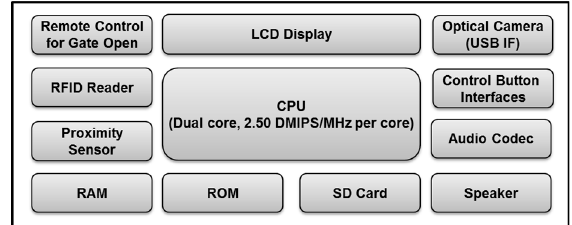
Figure 8. The hardware configuration of the proposed user-friendly stand-alone access control system based on human face recognition at a distance with RFID. DMIPS, IF: interface.